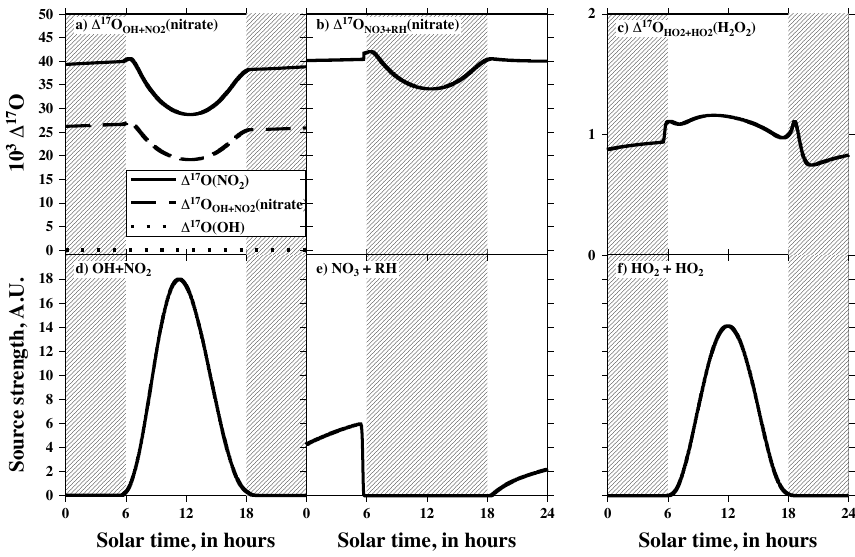
Fig. 4. Simulated diurnal variations of the isotopic signature 1 17 O i ( nitrate ) and 1 17 O i ( H 2 O 2 ) ( a – c ) and the strength ( d – f ) of the OH + NO 2 , NO 3 + RH nitrate production channel and H 2 O 2 production channel, respectively. Note that in the case of the OH + NO 2 reaction, the 1 17 O values of individuals precursors (OH and NO 2 ) are shown along with the isotopic signature of this reaction channel (see Sect. 2.4.1). Results originate from the base model run ( T = 293K, 45 ◦ N, see Sect. 3.4 for details) under the isotopic hypotheses of Case 3 (explicit NO x and HO x ). Hatched areas represent the period of the day when the considered reaction pathway proceeds insignificantly, thus the corresponding 1 17 O which could then be transferred to the reaction products is irrelevant. The diurnally-integrated isotopic source (DIIS) values correspond to the average of values from the upper panel, weighted by the values of the lower one. Note that the strength of the production pathways are expressed in arbitrary units different in each cases, thus the panels (d) to (f) cannot be directly compared. Table 6. Diurnally-integrated source isotopic signature (DIIS) for the four nitrate and H 2 O 2 production channels considered (in ‰ units). Overview of the results from three model runs carried out at different periods of the year (W=1 January, Sp.=1 April and Su.=1 July, respectively), under mid-latitude (45 ◦ N) remote boundary layer